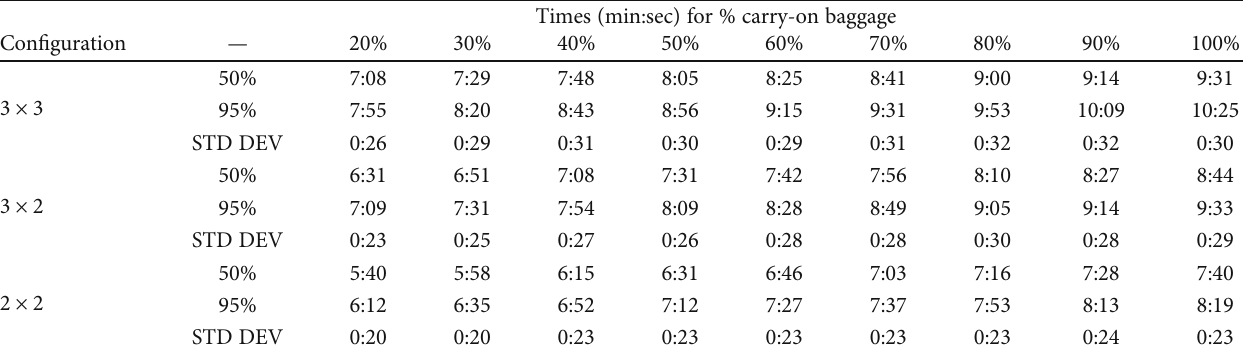
Times (min:sec) for % carry-on baggage